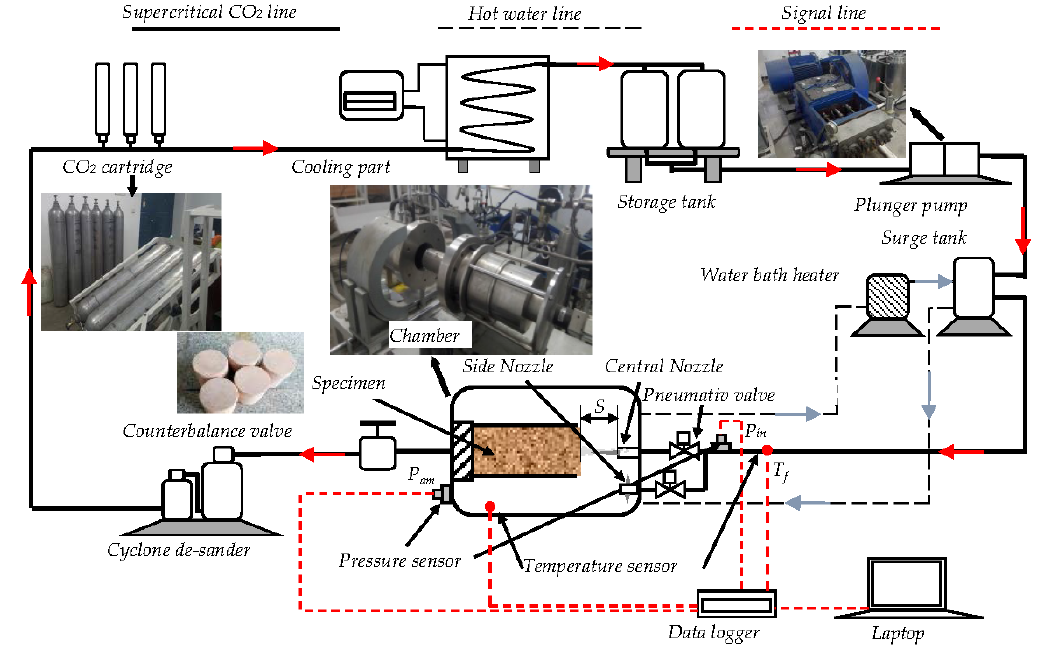
Figure 2. Schematic diagram of the rock erosion test system of a SC-CO 2 jet.